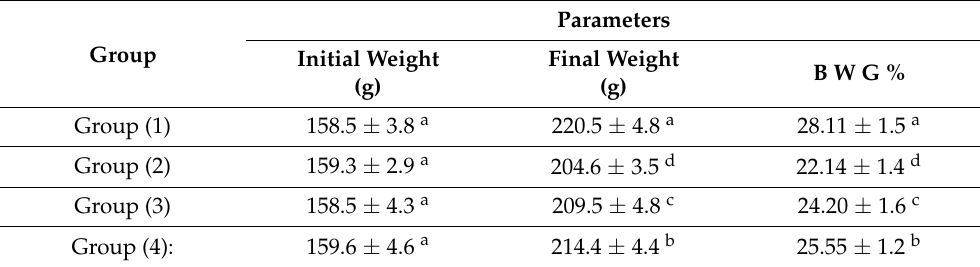
Table 3. Final weight and body weight gain of diabetic rats treated with fermented camel milk containing SFP.